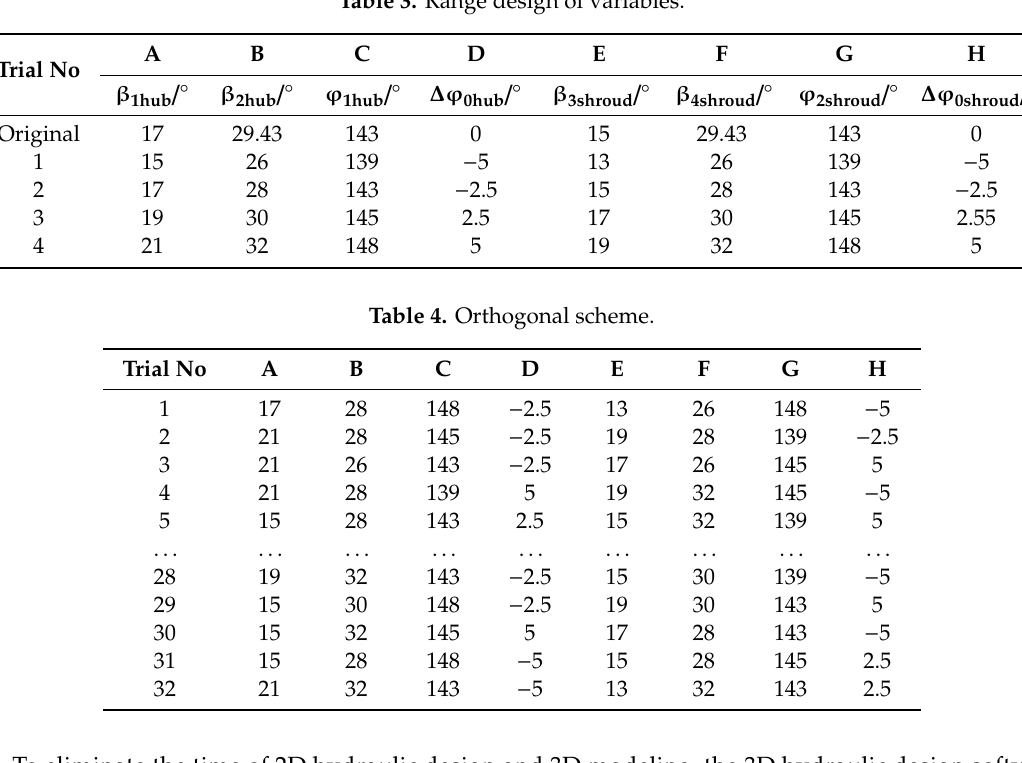
Table 3. Range design of variables.